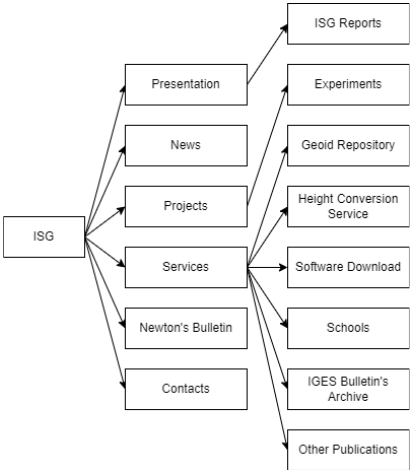
Figure 2. Website structure of the